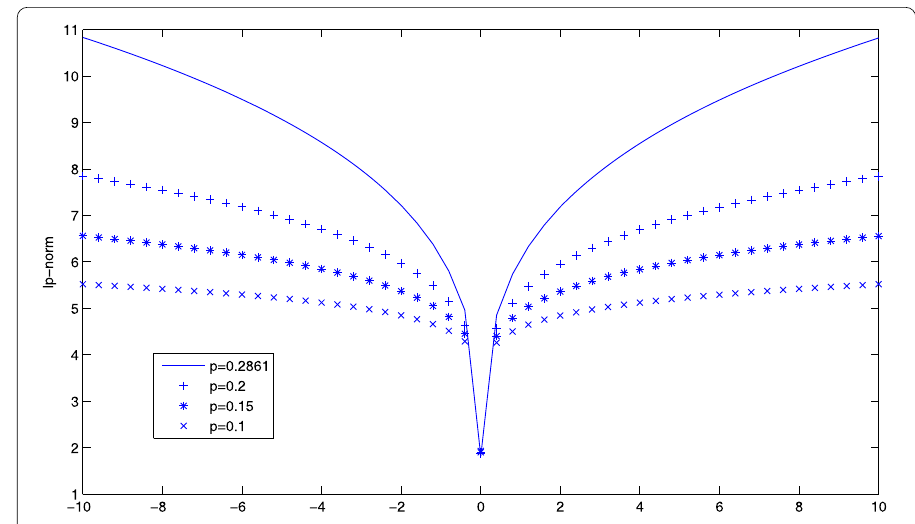
Figure 1 The p -norm of the solutions of the different cases in Example